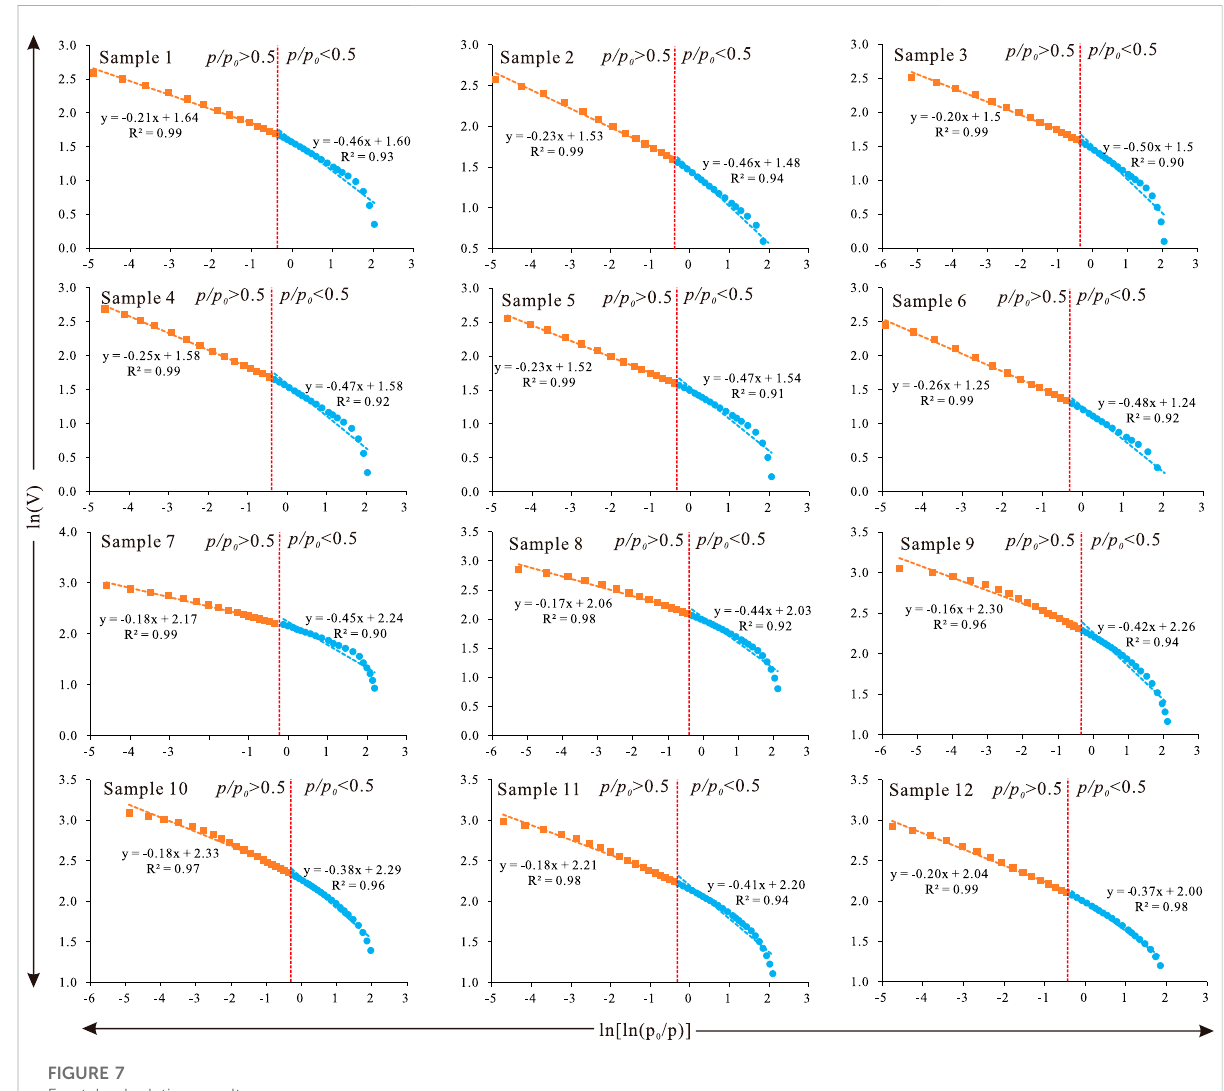
FIGURE 7 Fractal calculation